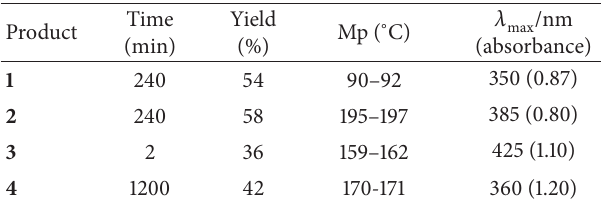
Table 1: Properties of new